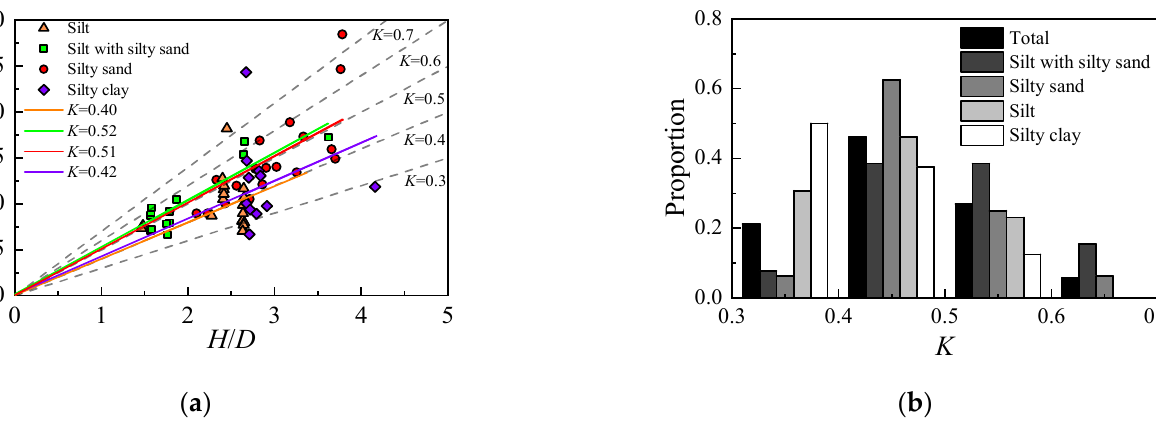
Figure 5. Statistical result of the trough width parameters K . ( a ) trough width parameter K vs. buried depth H , ( b ) probability distribution of K .